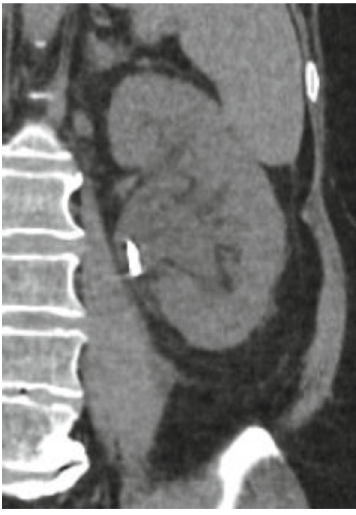
Figure 1: CT scan; persistent hydronephrosis despite DJ